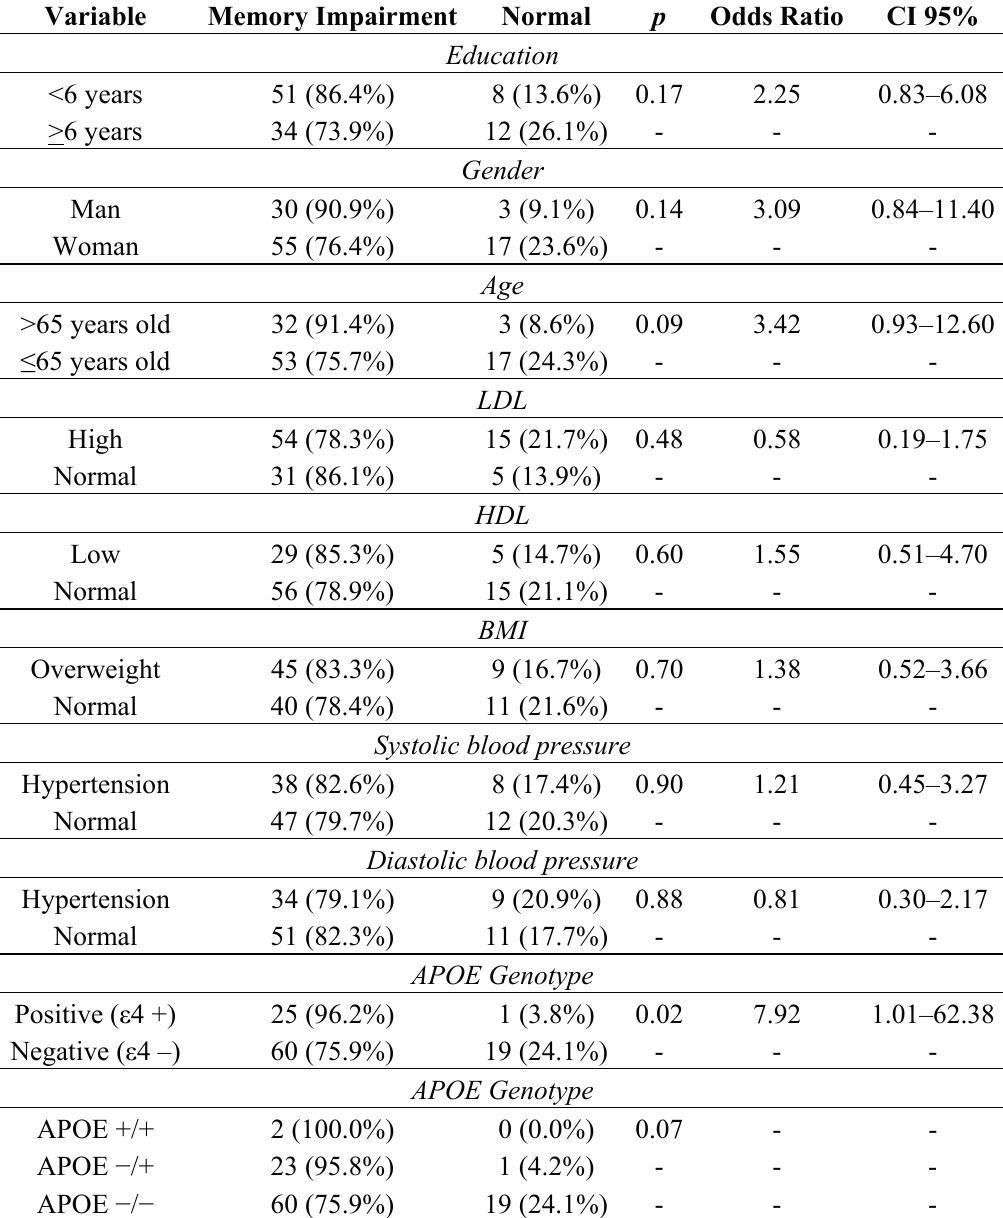
Table 1. Memory Impairment (Word List Memory Immediate Recall (WLM IR) <8) with Status of Demographic, Clinical, Laboratory and